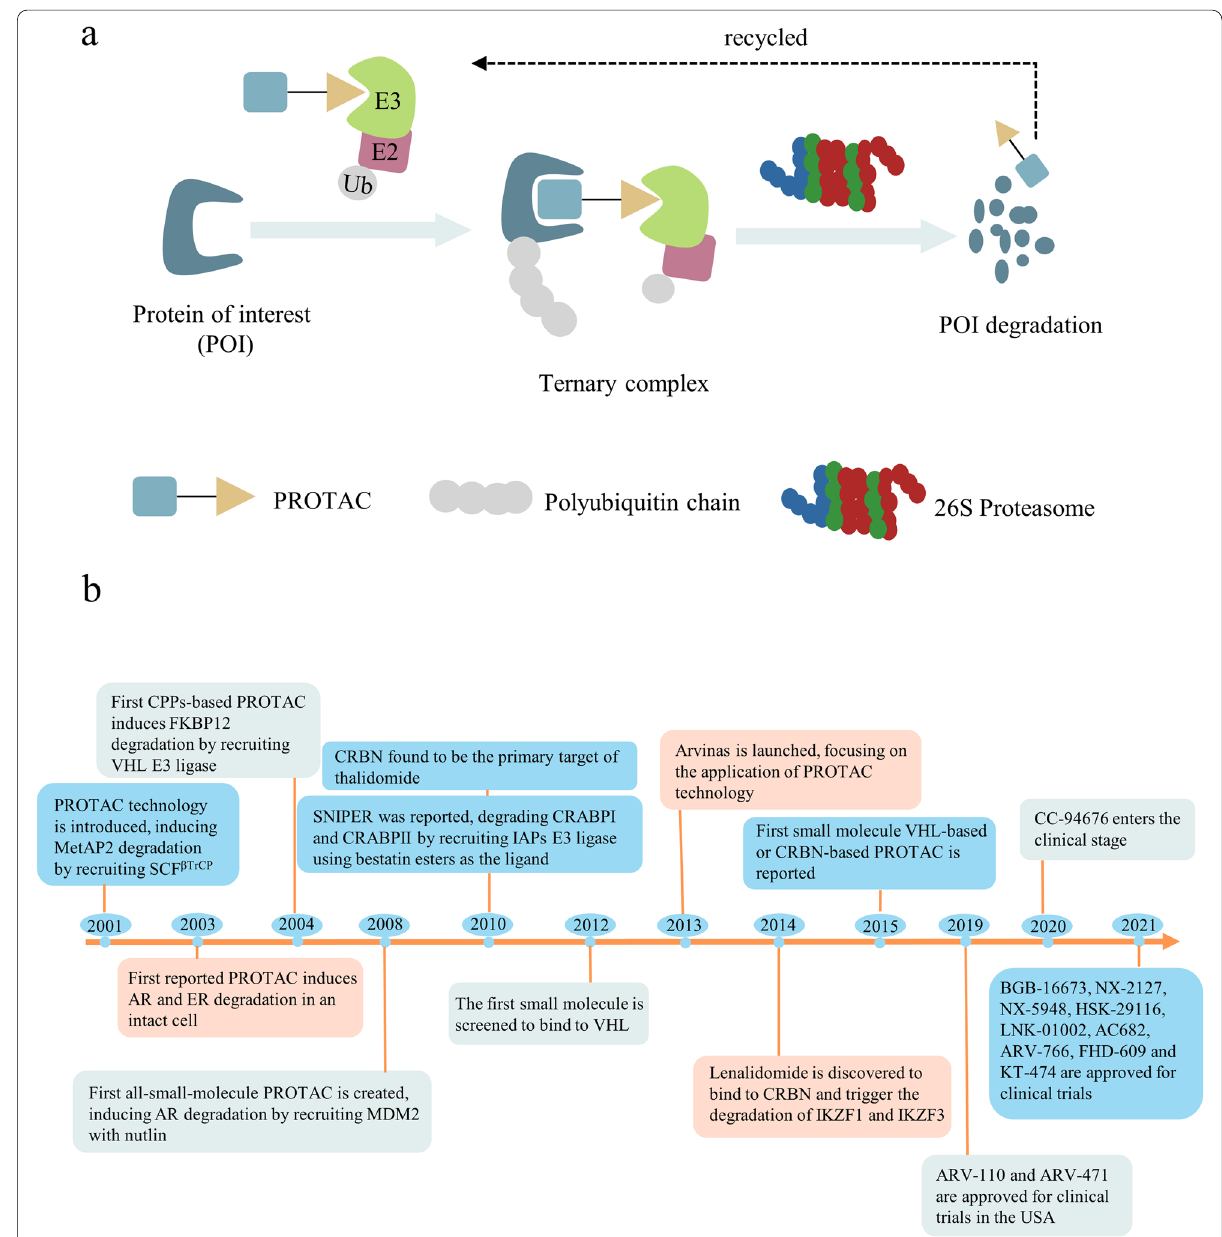
Fig. 1 a The mechanism of PROTACs based on the UPS. UPS consists of specific enzymes (E1, E2 and E3) modifying proteins with ubiquitin and the proteasome degrading the ubiquitin-tagging proteins. PROTAC contains a POI ligand, an E3 ligand and a linker. The E3-PROTAC-POI ternary complex induces the polyubiquitination and proteasome-mediated degradation of POIs. b Milestones in the development of PROTAC